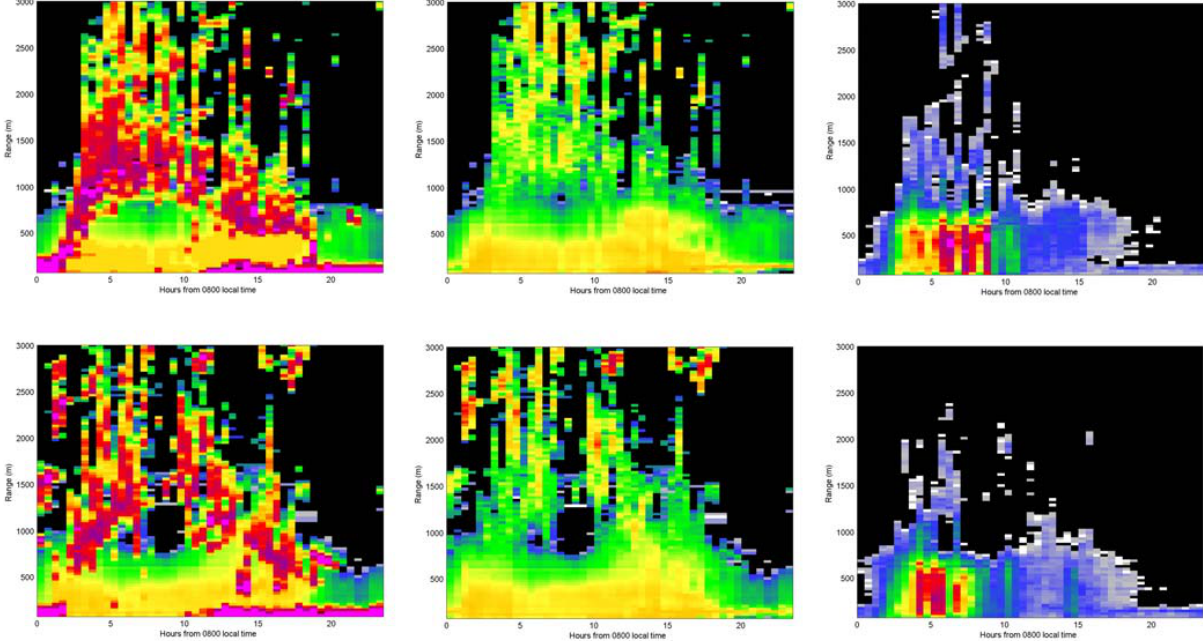
Fig. 5. These plots show diurnal cycles, as averaged over a week, for the first 2 weeks of the deployment. The top row correspond to week 1, starting 3 April 2008, and the second row to week 2. The three columns, from the left, are backscatter value (all data with SNR > − 17dB), backscatter value (data for SNR values between − 5dB and − 17dB) and standard deviation of the vertical velocity evaluated from all the data with an SNR > − 17dB. The backscatter colour scale is the same as shown in the lower panel of Fig. 3. The colour scale for the right hand column is as Fig. 8 but the range is 0.1–1.1ms − 1 . For each panel the horizontal axis is 24h starting at 08:00LT. The vertical axis is height and extends from